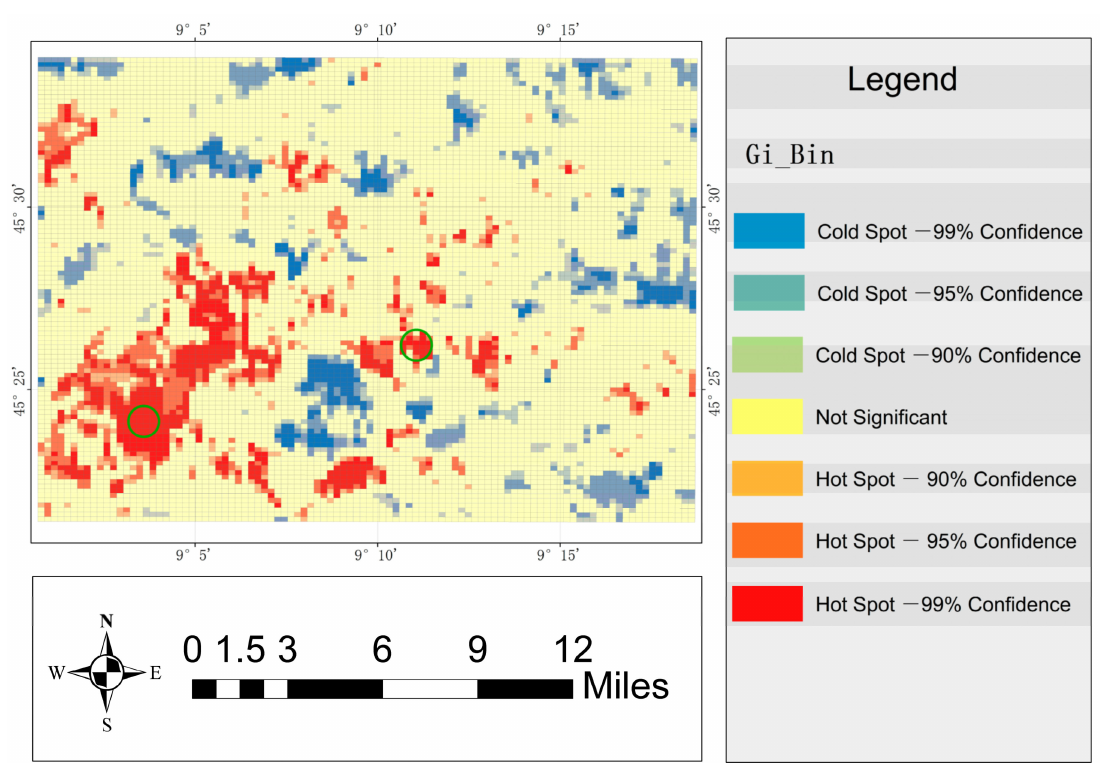
Figure 13. Spatial distribution of the detected hot/cold